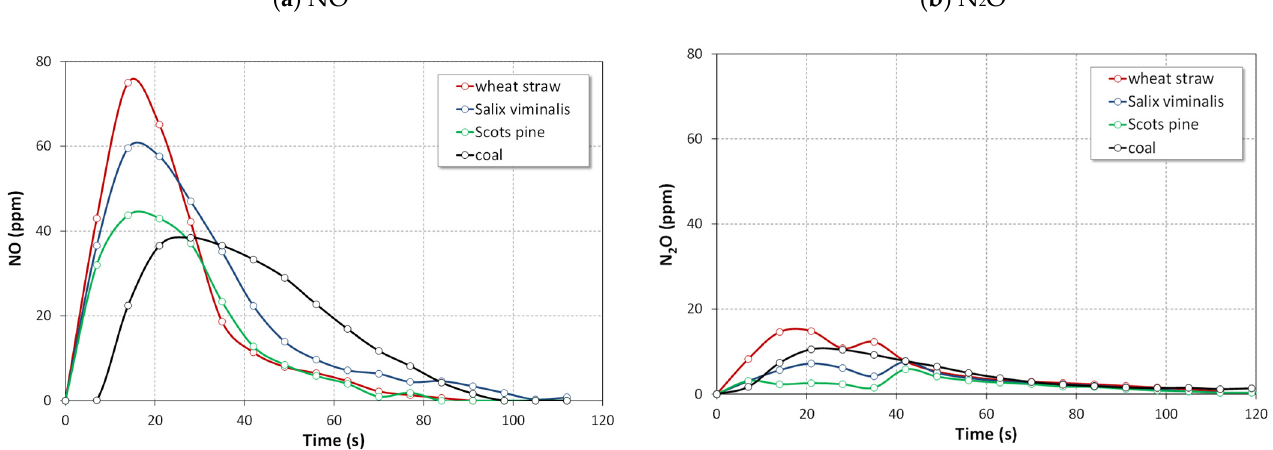
Figure 1. Impact of fuel type on the instantaneous NO ( a ) and N 2 O ( b ) concentrations during air combustion.